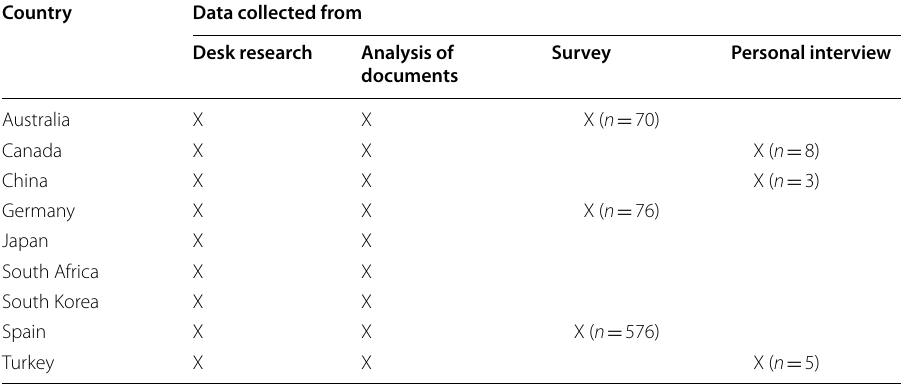
Table 2 Data collection instruments used in the country reports Country Data collected from Desk research Analysis of